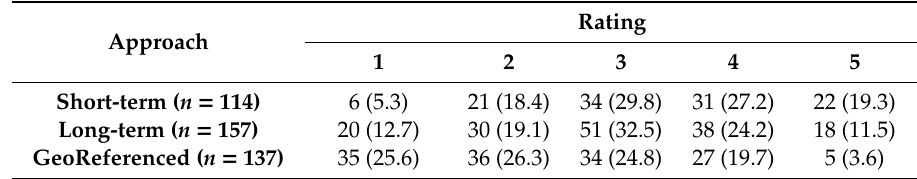
Table 3. Absolute (relative) frequencies of the ratings attributed to each article category in the recommended